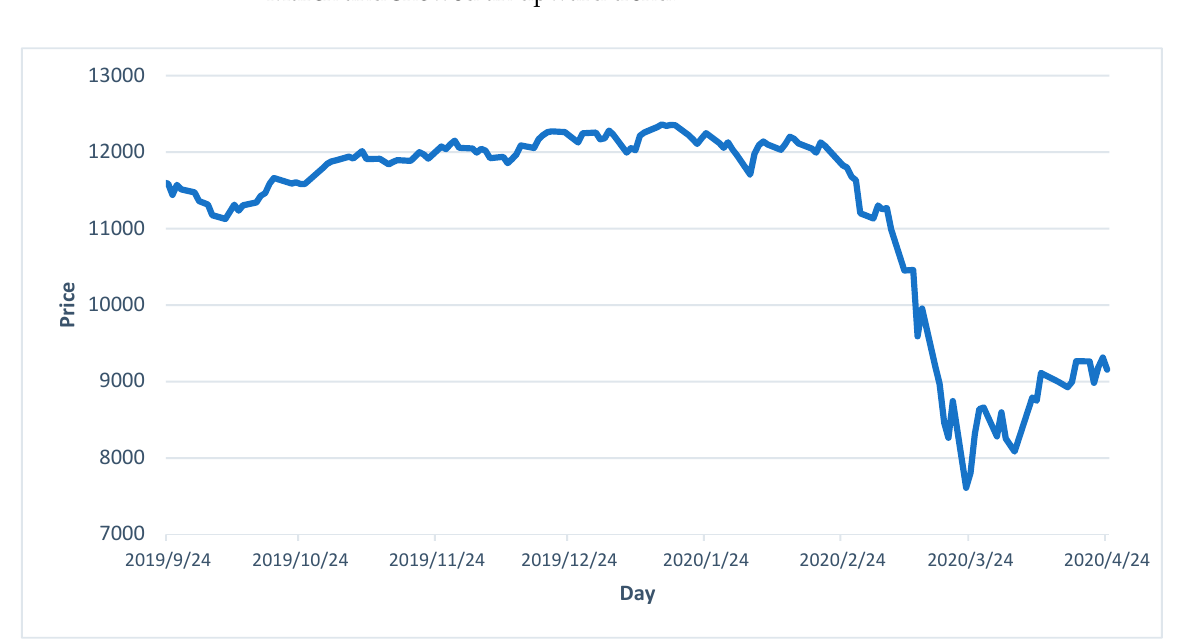
Figure 1. NIFTY50 price chart (source: NSE).